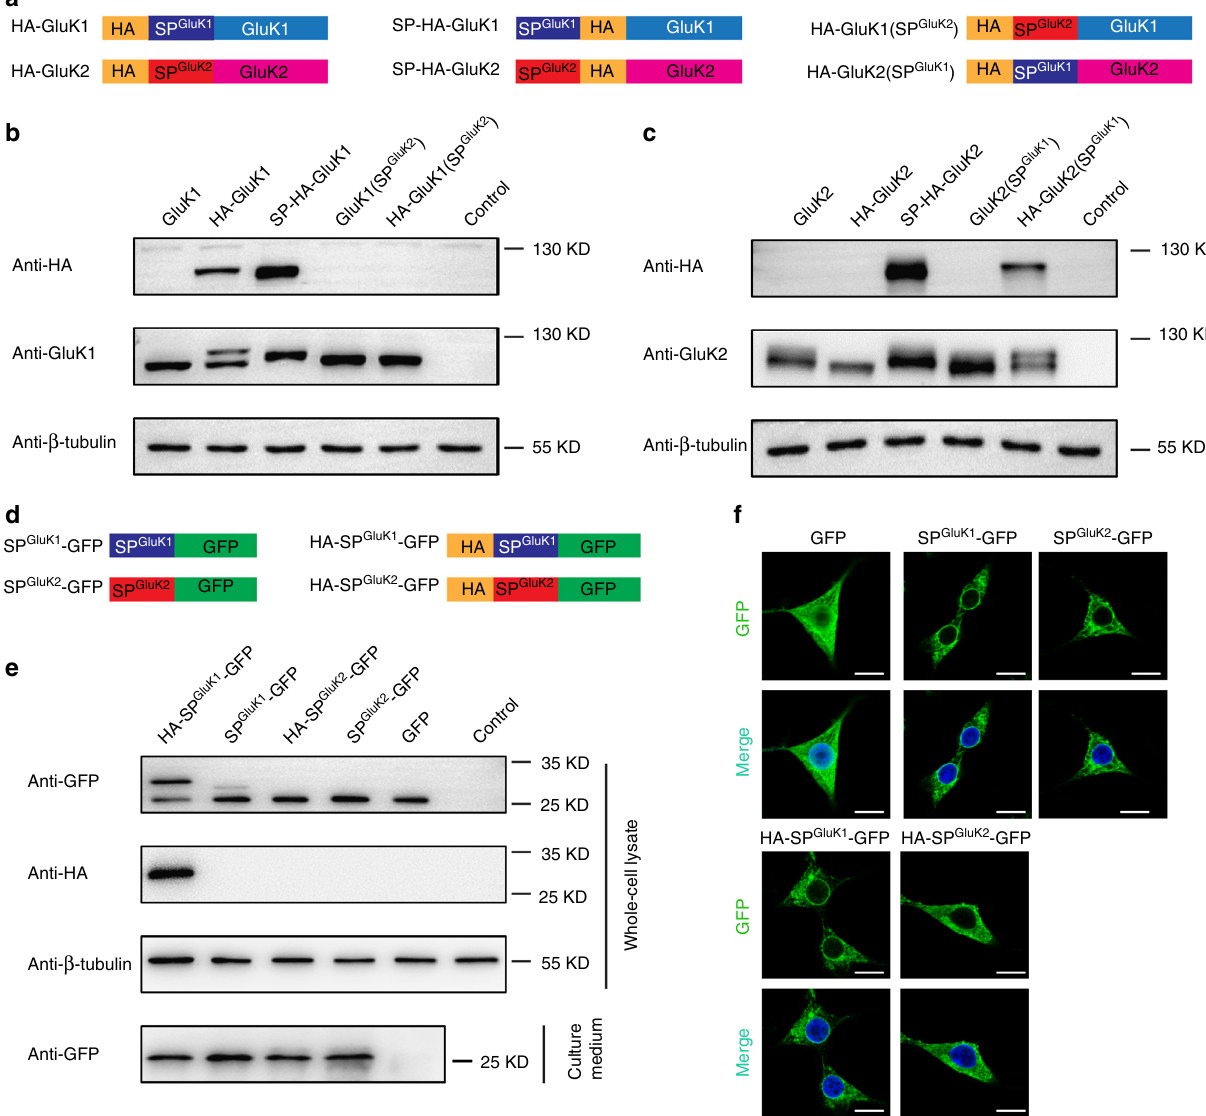
Fig. 2 The GluK1 signal peptide is fully cleaved in the ER. a The schematic cartoons for the constructs of HA-tagged receptors used for transfections in b and c . b , c Immunoblot analysis of proteins extracted from HEK 293T cells with indicated transfections of wild-type and mutated GluK1 ( b ) and GluK2 ( c ) receptors. Total protein loaded was 20 μ g for each sample. Panel 1, immunoblots were probed with anti-HA to detect the recombinant proteins. Panel 2, gel-shift experiment was applied and immunoblots were probed with anti-GluK1 and anti-GluK2 antibodies respectively to detect the recombinant proteins. Panel 3 was probed with anti- β -tubulin antibody as loading control. d The schematic cartoons for the constructs used for transfections in e and f . e Immunoblot analysis of the intracellular expression of tethered proteins (panel 1 – 3) and extracellular secreted GFP (panel 4) using indicated antibodies. f Intracellular localization of fl uorescence signals of signal peptide-tethered GFP or non-tethered GFP in HEK 293T cells (green). The nucleus was stained with DAPI (blue). Scale bars: 10 μ